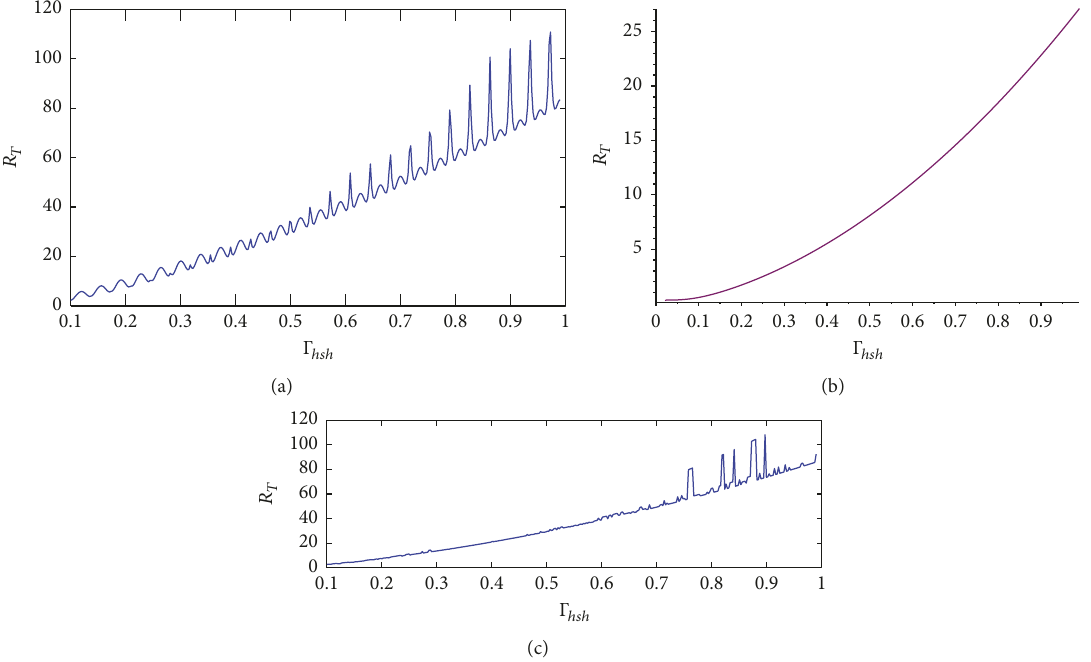
Figure 12: Effect of infection rate ( Γ ℎ𝑠ℎ ) on the periodic reproduction